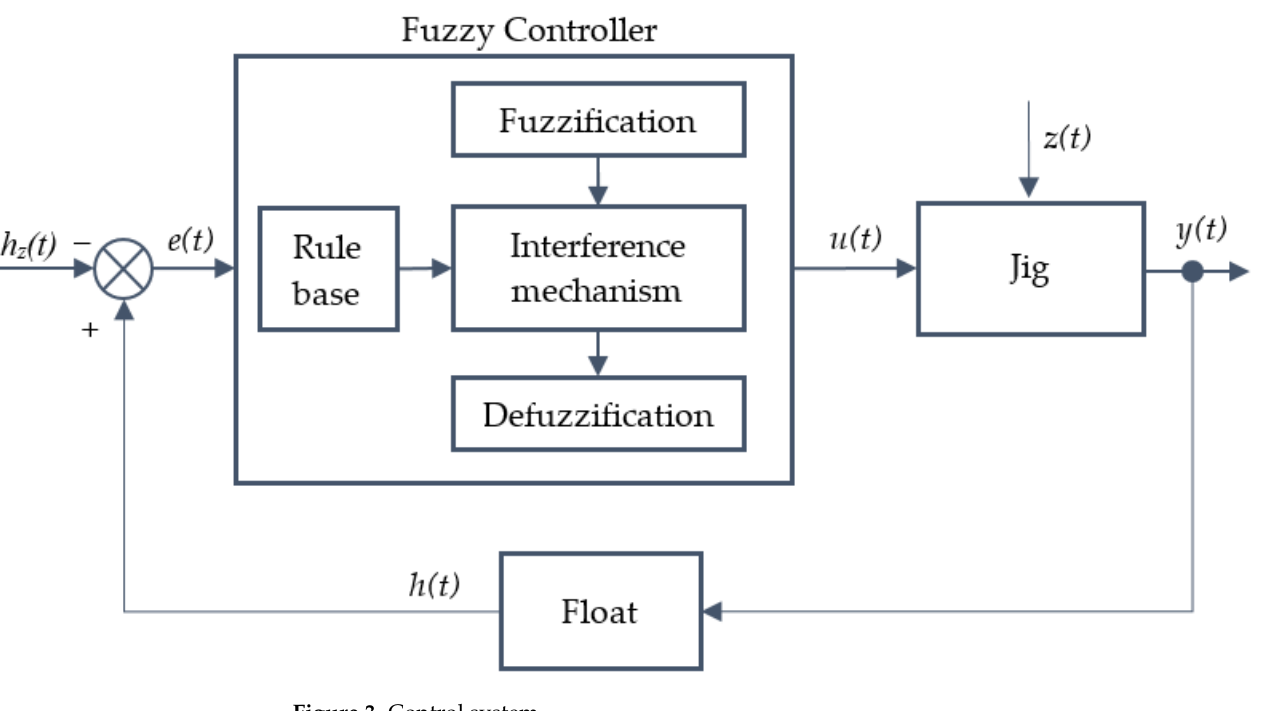
Figure 3. Control system.